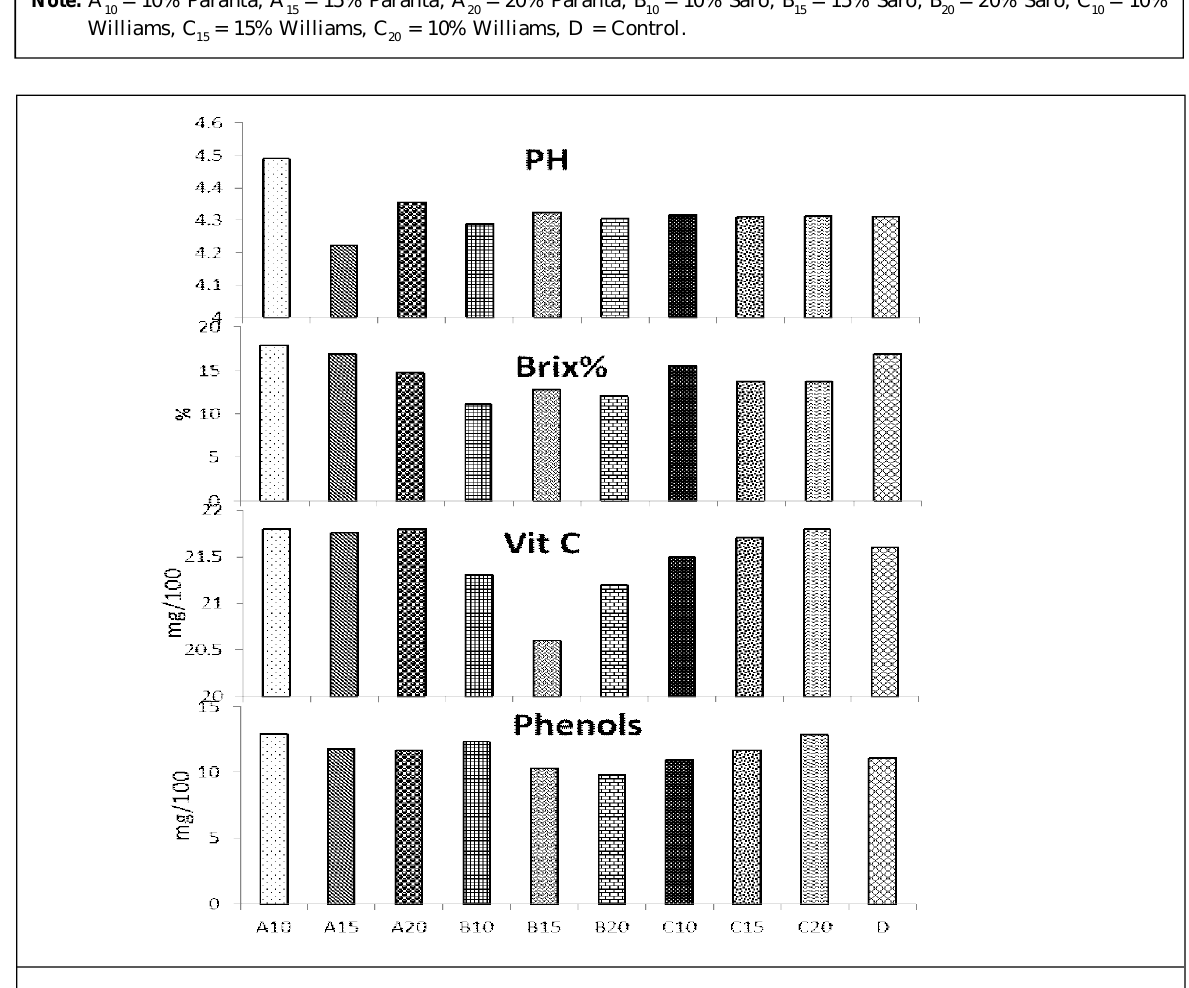
Figure 2: The physico-chemical properties of partially fortified yogurt with variety of banana Note: A = 10% Paranta, A = 15% Paranta, A = 20% Paranta, B 10 15 20 Williams, C = 15% Williams, C = 10% Williams, D = 15 20